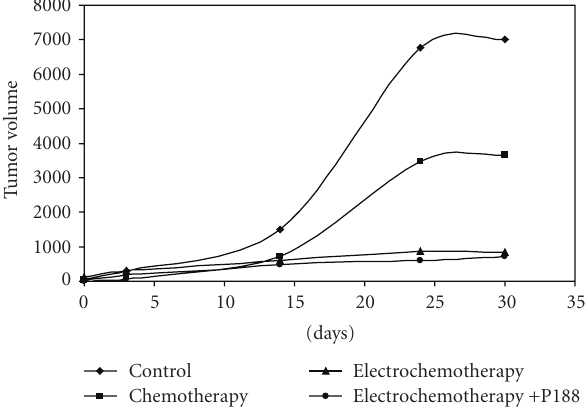
Figure 7: Growth curves of HeLa tumors implanted in Nude mice: control (without any treatment); chemotherapy with cis- platin; electrochemotherapy with cisplatin injected intratumorally, electrochemotherapy in the presence of P188 injected 5 minutes after pulses intraperitoneally. The observed time was 30 days. Points are mean value of three tumors. Standard errors are omitted due to the overlap of the